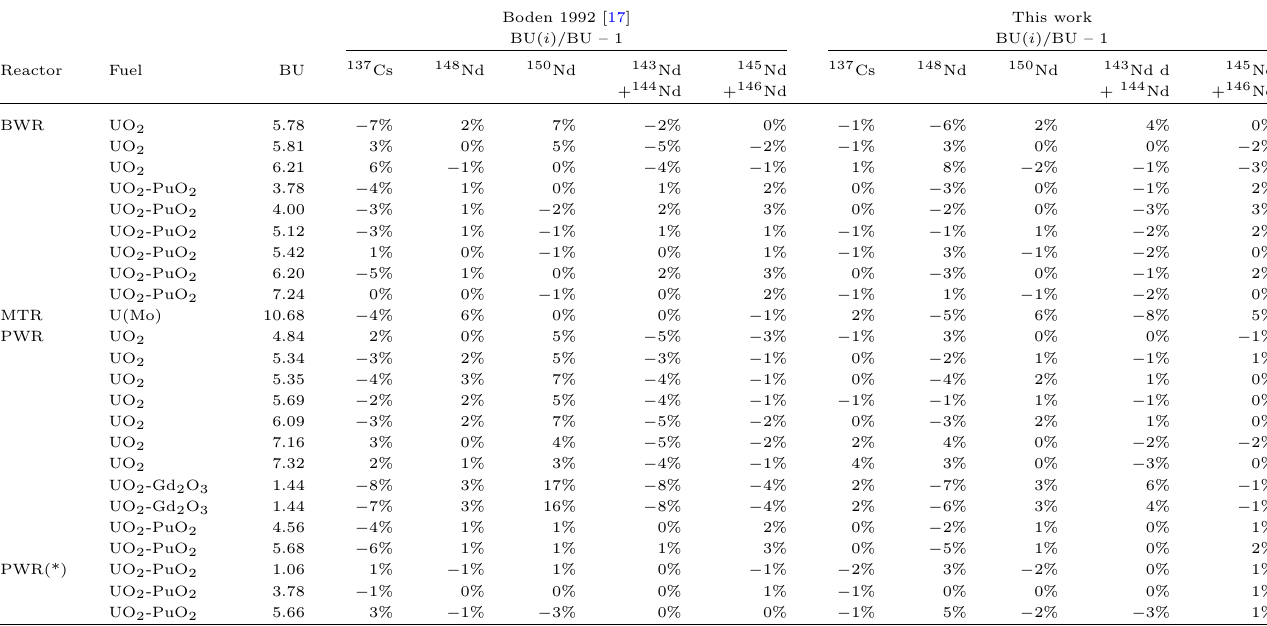
Table 3. Comparison of the burnup predictions with the Boden 1992 method [17] and the method proposed in this work, for several RCA assays in SCK CEN laboratories. Various reactor designs and fuel types were investigated, including gadolinium-doped